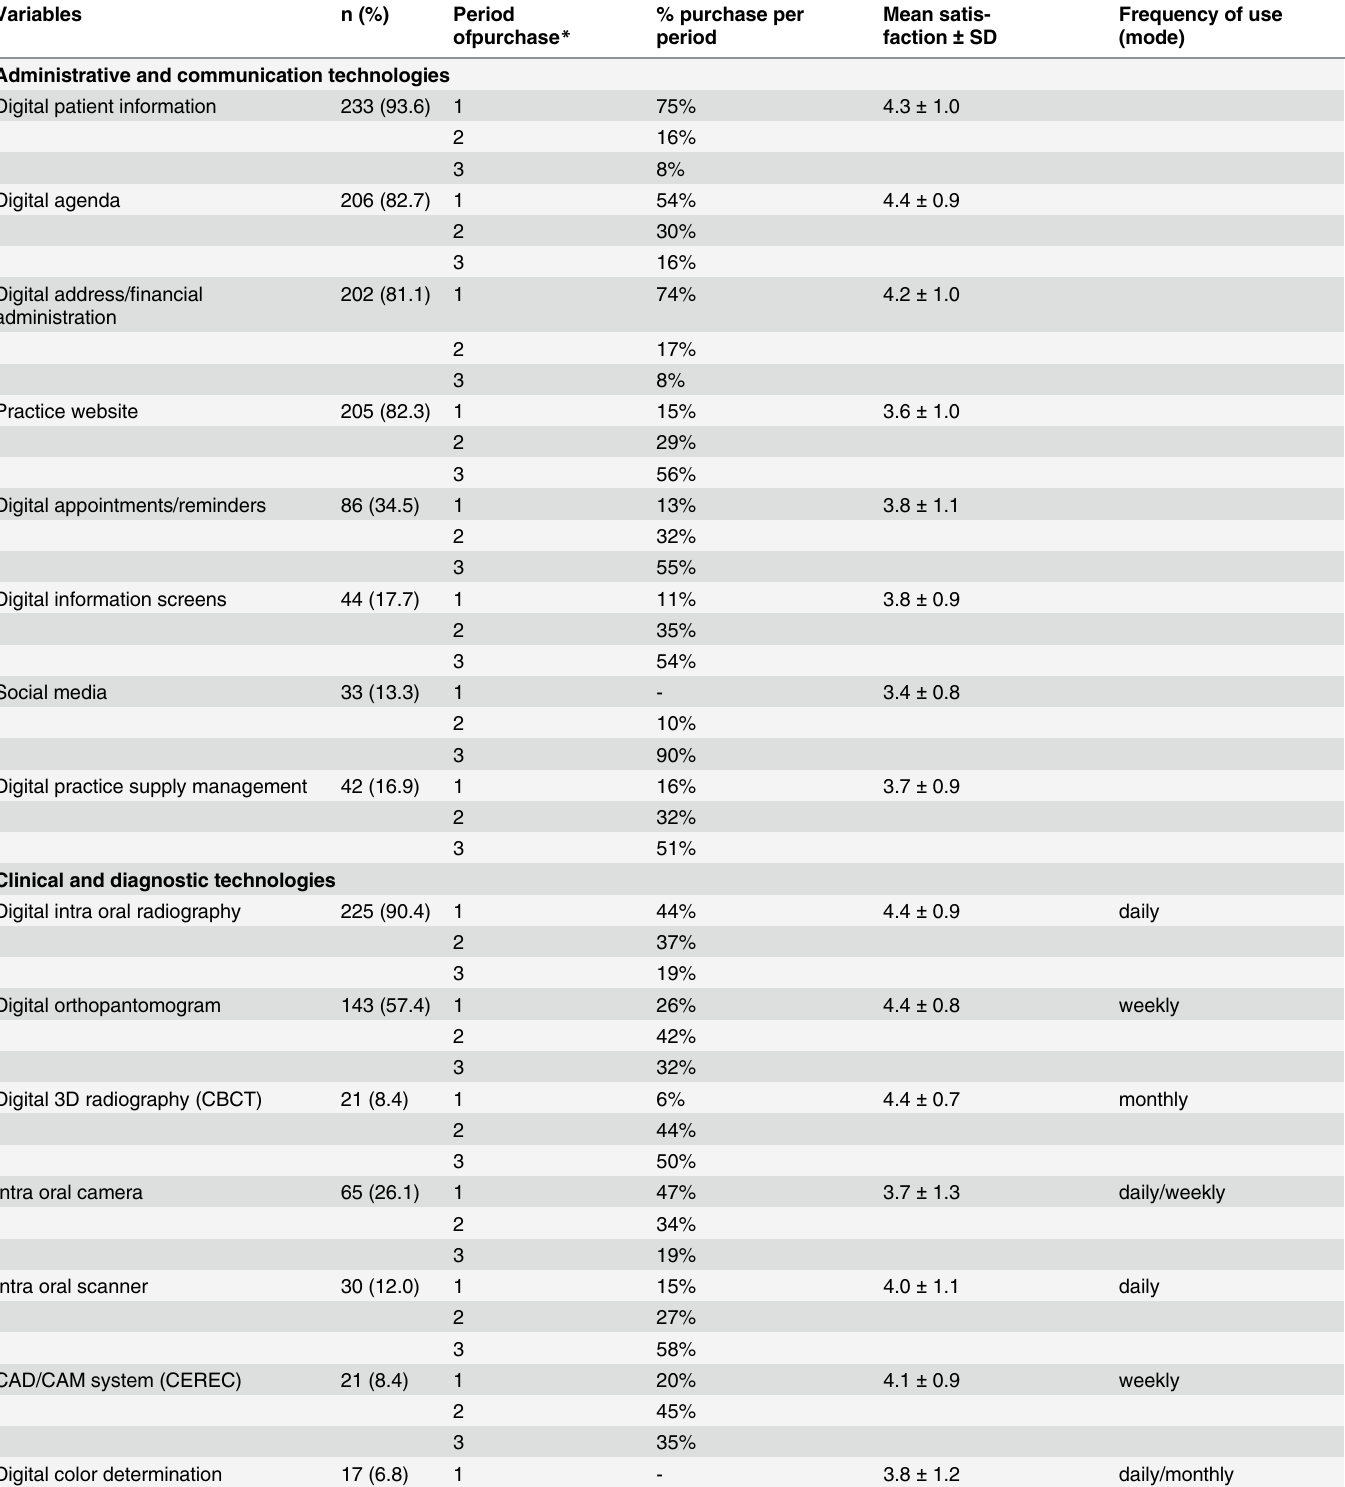
Table 1. Description of digital dental technology use among Dutch